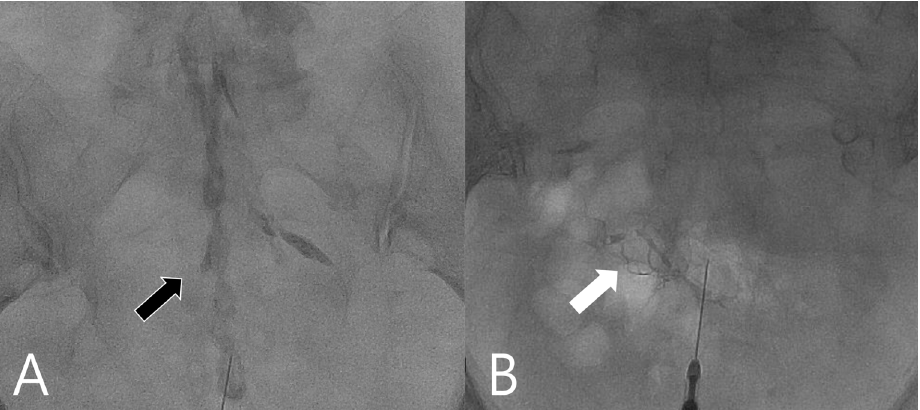
Figure 1. Fluoroscopy image of intraepidural and intravascular injection. ( A ). Intraepidural injection shows contrast in the epidural space (black arrow) with Christmas tree appearance. ( B ). Intravascular injection shows contrast in small arteries (white arrow) with early contrast washout.